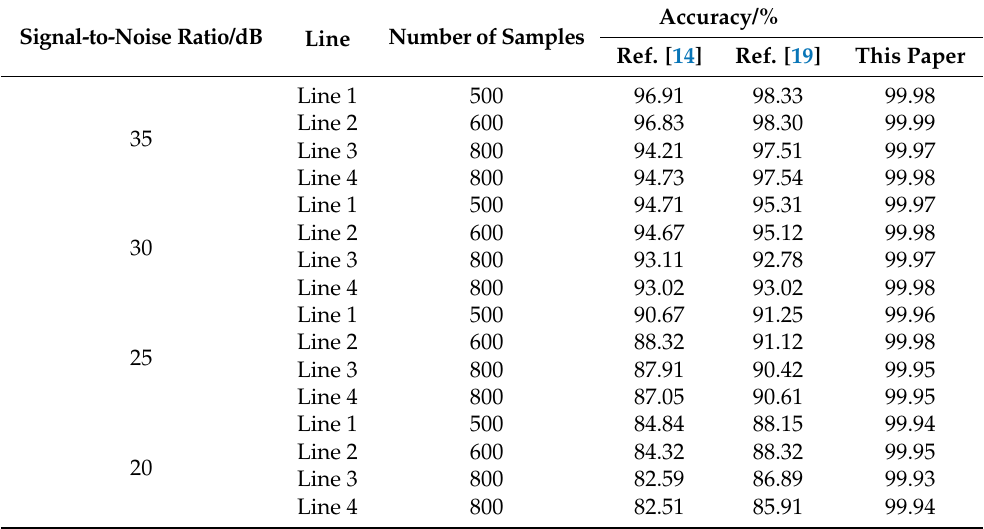
Table 5. Comparison of line selection accuracy under different signal-to-noise